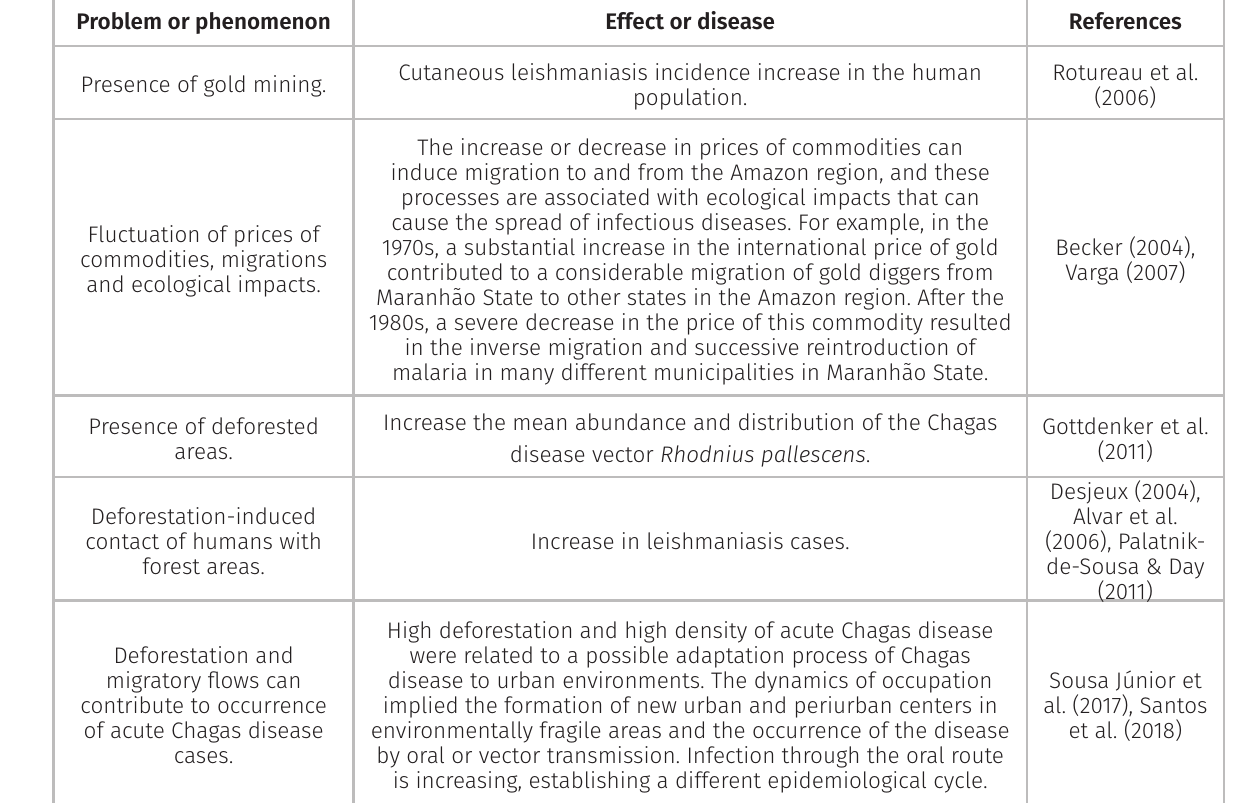
Cutaneous leishmaniasis incidence increase in the human population.